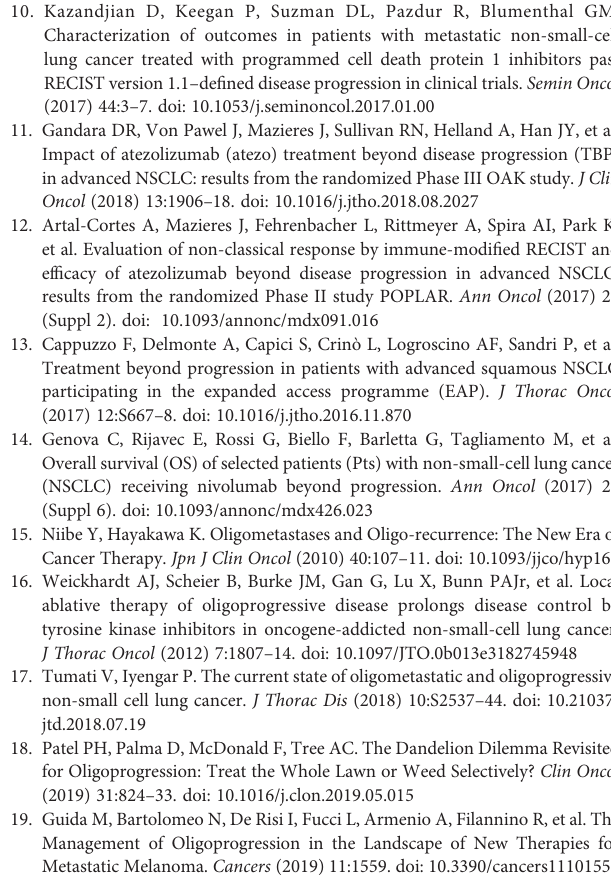
Supplementary Figure 2 | Kaplan-Meier curves of the PFS2 and OS of patients with longer or shorter ICI treatment. The longer ICI (>7.5 months) treatment group showed superior mPFS2 (A) and mOS (B) compared with the shorter ICI ( ≤ 7.5 months) treatment group; the mPFS2 (A) were 16.6 and 8.3 months, and the mOS (B) were 29.8 and 12.7 months, respectively ( p < 0.0001). Supplementary Figure 3 | OS between different therapy groups in systemic progressioncohort.(A)ThemOSwere23.8and10.2months( p < 0.001)in patients receiving systemic treatment (Yes) or best supportive care (No), respectively. (B) Subgroup analysis of OS in patients with different treatment strategies: ICI plus anti-angiogenesis or chemotherapy (4 + 1/3), chemotherapy only (3), anti- angiogenesis only (1), the mOS were 23.1, 23.8 and 12.4 months ( p = 0.6 ), respectively. Supplementary Figure 4 | OS between different therapy groups in oligoprogressive cohort. (A) The mOS were 26.4 and 20.8 months ( p = 0.006) in patients treated with continued ICI and local radiotherapy with/without anti- angiogenesis (a1) and other strategies (others). (B) Subgroup analysis of OS in patients with different treatment strategies: ICI plus local therapy (a1), ICI plus anti- angiogenesis or chemotherapy (a2), local therapy only (a3), and anti-angiogenesis or chemotherapy (a4), the mOS were 26.4, 23.1, 10.8 and NR months ( p < 0.001),